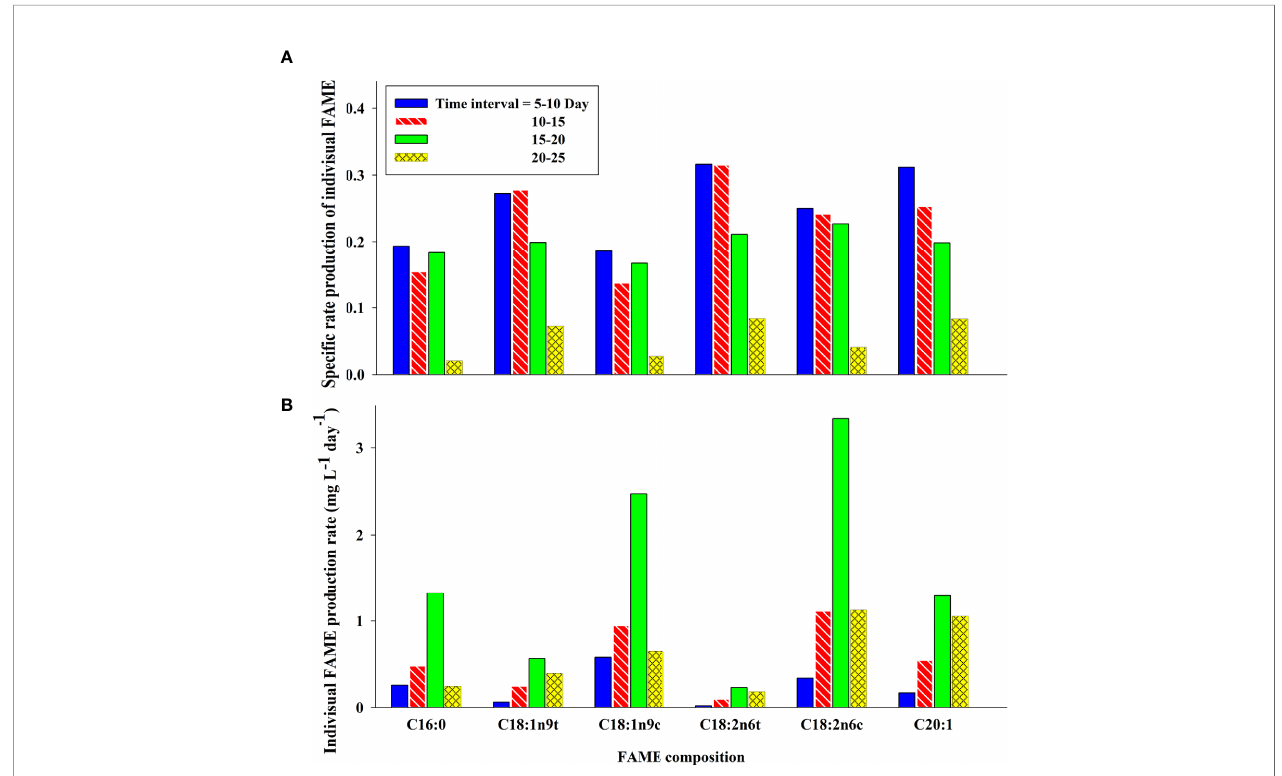
FIGURE 4 | Speci fi c rate of individual FA production (A) and productivity of individual FAs (B) of C . vulgaris as a function of